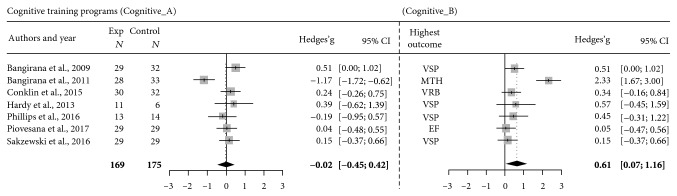
Forest plots showing the number of participants per group, effect size estimates (Hedges's g), and 95% confidence interval of each study, comparing cognitive training outcomes with control condition's outcomes. Model Cognitive A depicts the meta-analytic model that considers, for each study, a combined mean value representing the mean value of multiple outcomes relative to all cognitive domains. Model Cognitive B depicts the meta-analytic model that considers, for each study, the highest outcome domain. Note: VSP = visuo-spatial skills; MTH = math; VRB = verbal; EF = executive functioning.